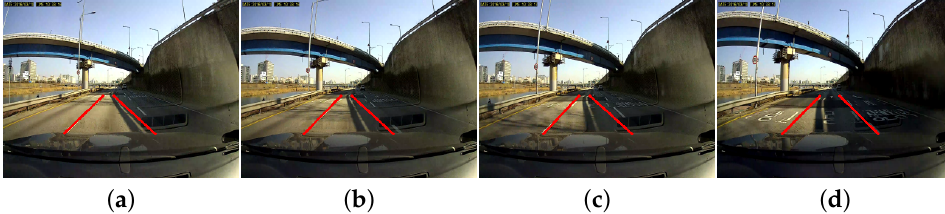
Figure 9. Sample result images of false detection in consecutive frames in the daytime sequence on KIST dataset: ( a ) T frame; ( b ) T+1 frame; ( c ) T+2 frame; and ( d ) T+3